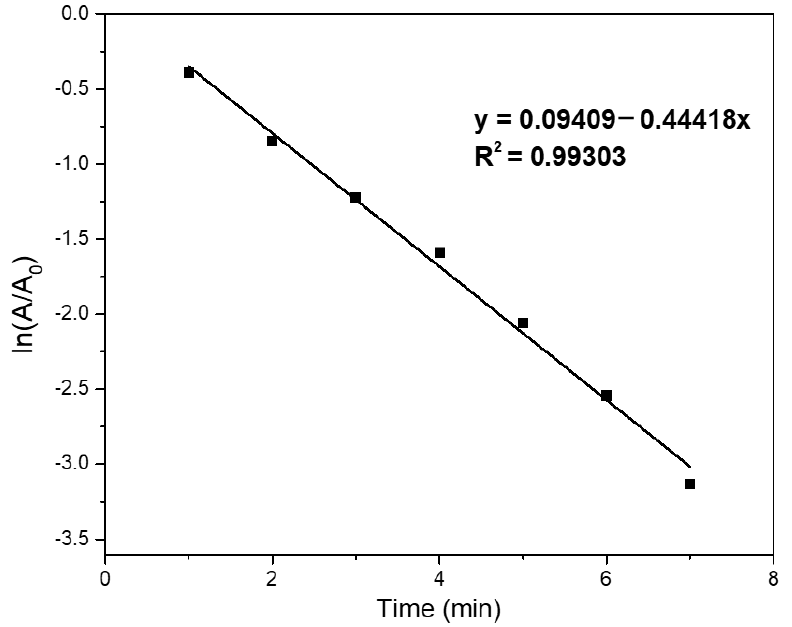
Figure 8. Plots of ln(A t /A 0 ) as a function of the reaction time for the catalytic reduction of 4NP to 4AP over the prepared ZrP@PDA/Au catalyst.